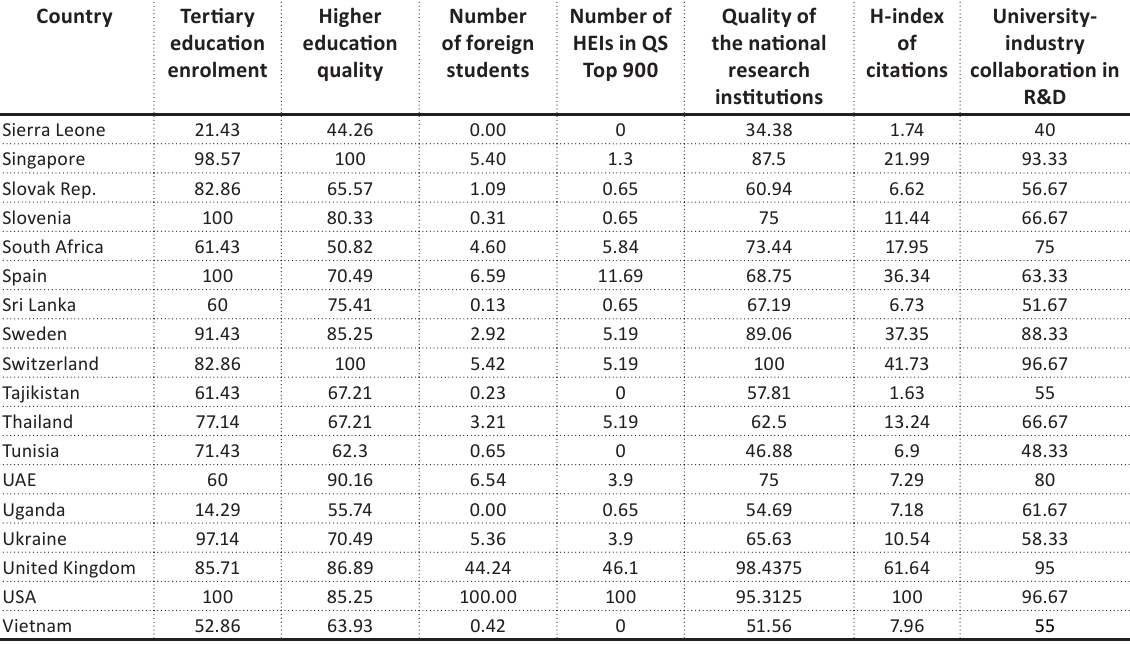
Table A1 (cont.). Data used for calculations of Higher Education Systems’ Ranking and cluster analysis (standardized)